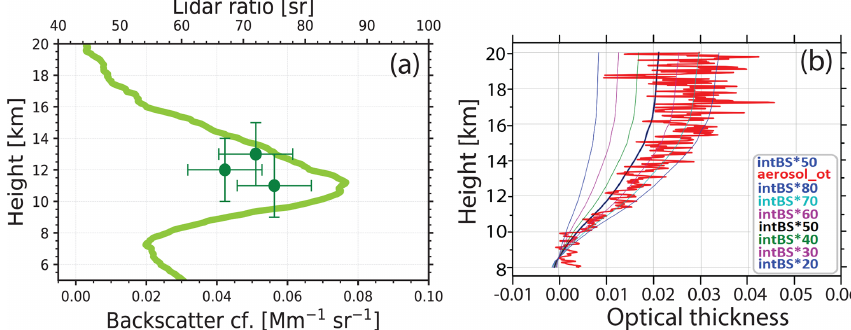
Figure 11. (a) Particle backscatter coefficient (light green, 532nm, 500m vertical signal smoothing) and corresponding lidar ratio (dark green circles, 4000m vertical smoothing, smoothing range is indicated by vertical bars) determined from the Polly observations on 7 February 2020, 00:00–24:00UTC. Horizontal bars indicate 1 standard deviation uncertainty. (b) Profile of particle optical thickness (thick red profile) from 8km up to height z as directly measured with the HSRL at 532nm (aerosol_ot) and alternatively calculated from the integral (intBS) of the independently measured backscatter coefficients (above 8km height up to height z ) multiplied by seven different lidar ratios from 20–80sr. The best match is obtained for a typical wildfire smoke lidar ratio of 70sr. HSRL signal profiles are averaged for the time period from 7 February at 00:00UTC to 8 February at